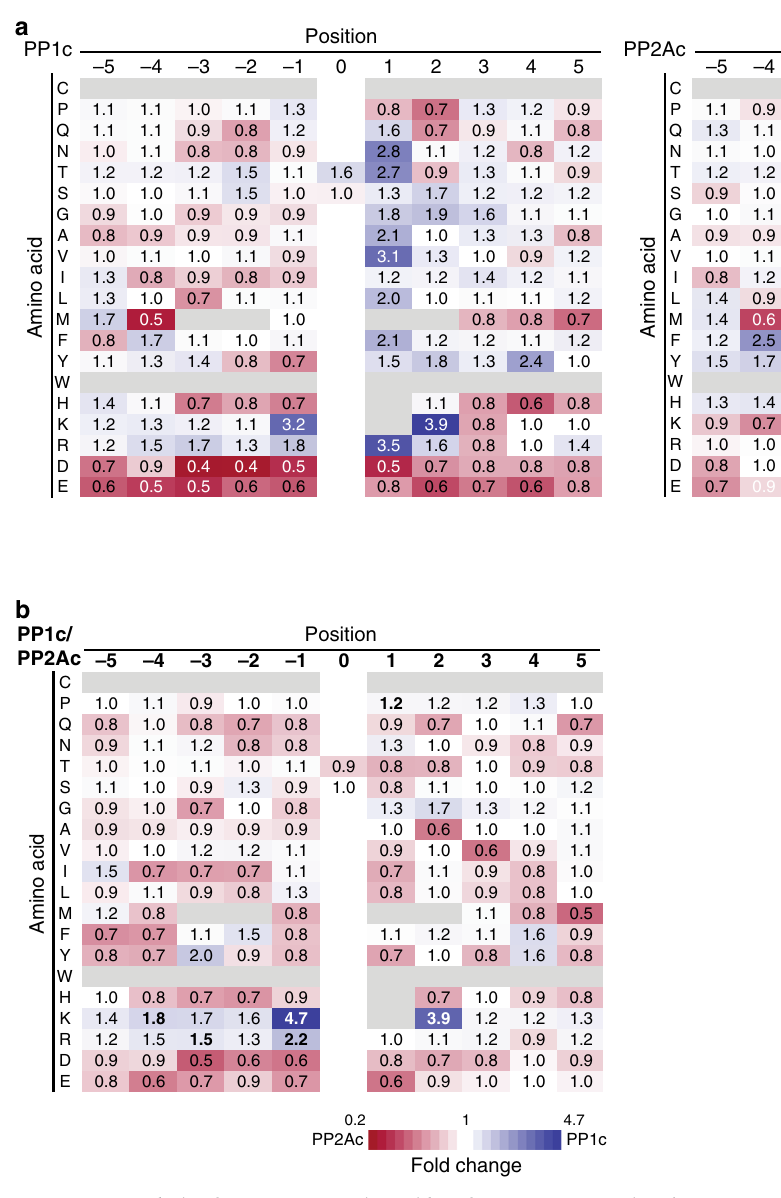
Fig. 4 Heat-map analysis of PP1c/PP2Ac amino acid preference. Amino acid preference surrounding pSer/pThr for PP1 and PP2A on the protein level from the phosphoproteomic data (Supplementary Data 2). Amino acids with <25 raw counts in a given position were excluded and are marked in gray. a Color coding represents fold-change of the relative abundance of a given amino acid in a given position between phosphatase-sensitive/insensitive phosphorylation sites. b Direct comparison of PP1c and PP2Ac fold changes displayed in ( a ). Blue highlights amino acids selectively preferred by PP1c, and residues statistically different between PP1c and PP2Ac (adjusted p -value <0.01) according to a two-sided Fisher ’ s exact test are highlighted in bold. Please see Methods and Source Data for details and exact p -values. Source data are provided as a Source Data fi